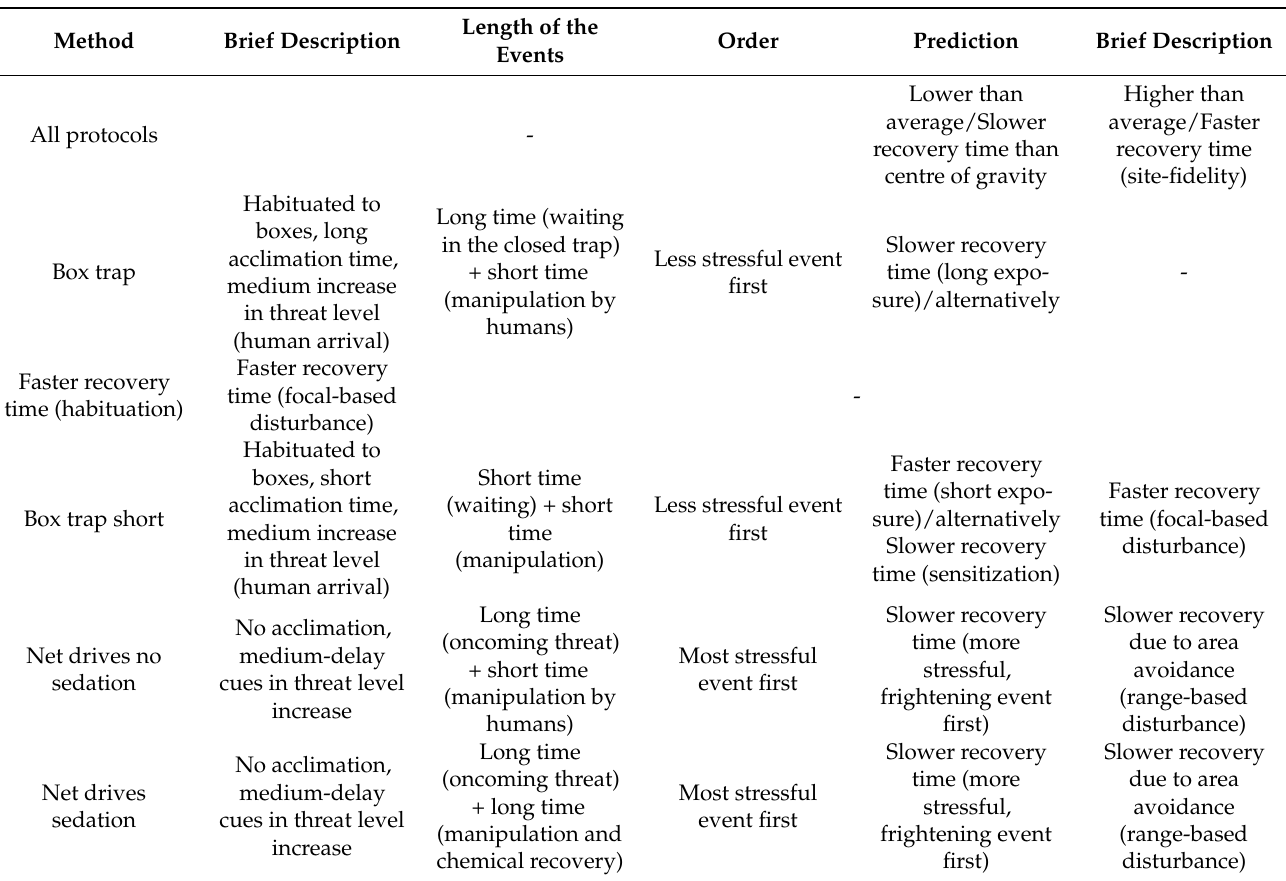
Table 2. Brief description of capture methods and related predictions for the capture and release metrics (distance between successive locations, and distance to the centre of gravity of